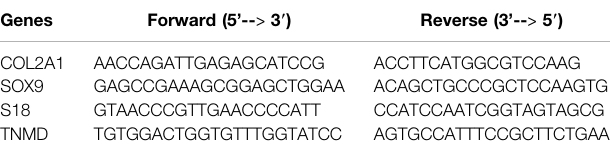
TABLE 1 | Primer sequences used for qRT-PCR